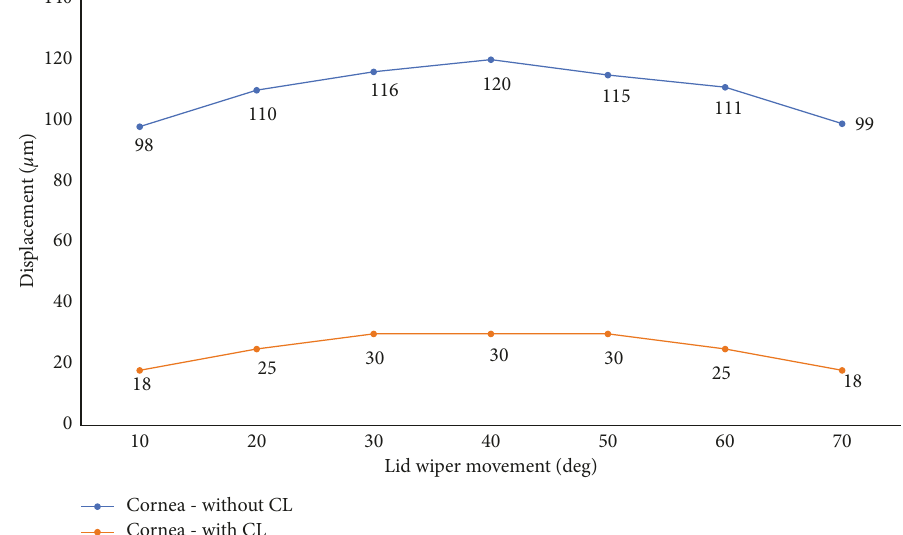
Figure 10: Displacement ( µ m) in the cornea during blink without and with CL when the lid wiper is moved at different positions from superior (10 ° ) to inferior cornea (70 ° ) (value of the data labels shows displacement; unit: µ m). Graph drawn with Microsoft Excel